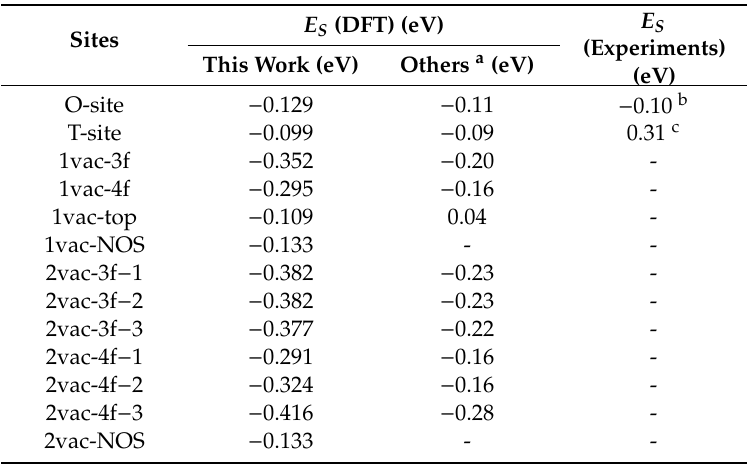
Table 1. Calculated solution energies ( E S ) of H in interstitials and vacancies (monovacancy or divacancy). The experimental data are from ref. a [41], b [42] and c